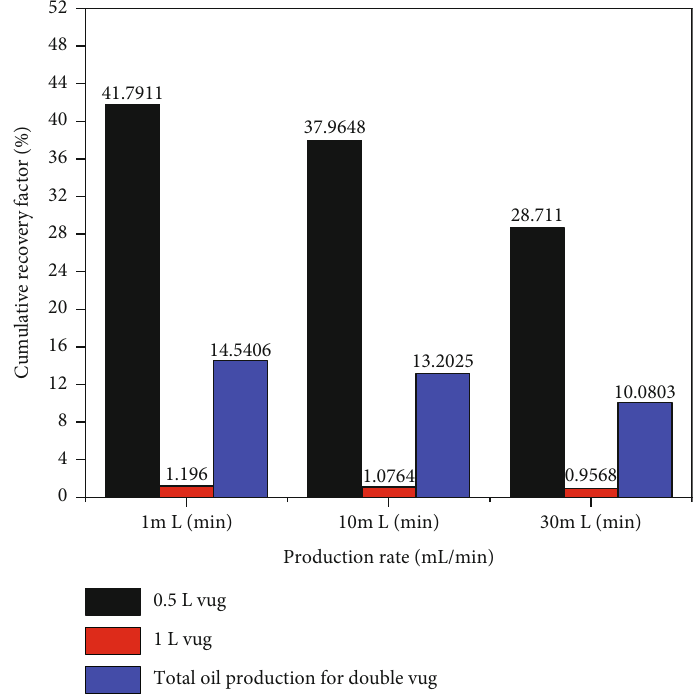
Figure 11: Column chart of cumulative recovery percent in high-pressure physical property experiments (di ff erent production